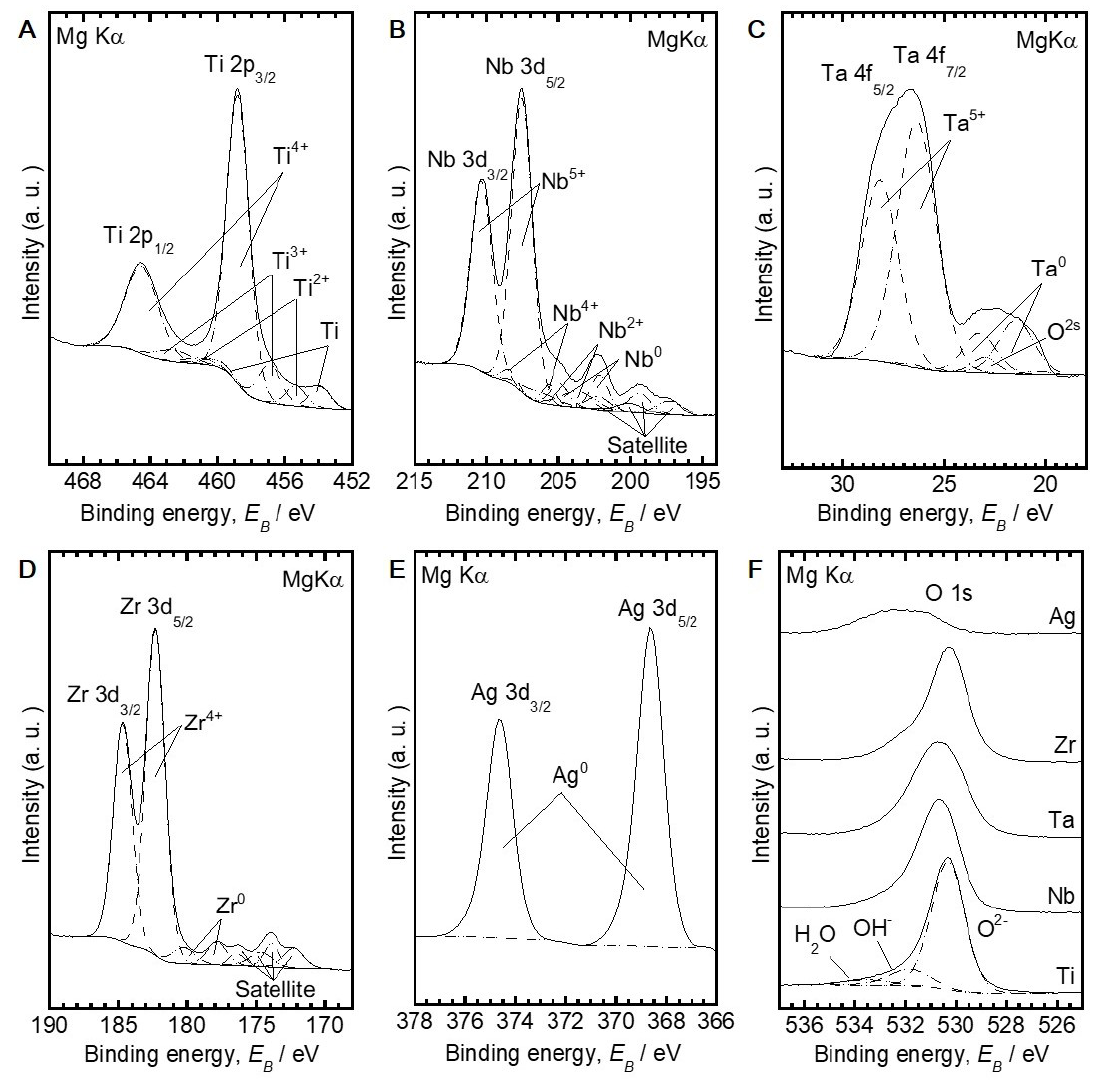
Figure 2. XPS narrow scan spectra around ( A ) Ti 2p, ( B ) Nb 3d, ( C ) Ta 4f, ( D ) Zr 3d, ( E ) Ag 3 d, and ( F ) O 1s electron binding energy regions obtained from the specimens. Table 1. The composition and thickness of the passive layer on each metal specimen calculated from the XPS measurement with a detection angle of 90 .